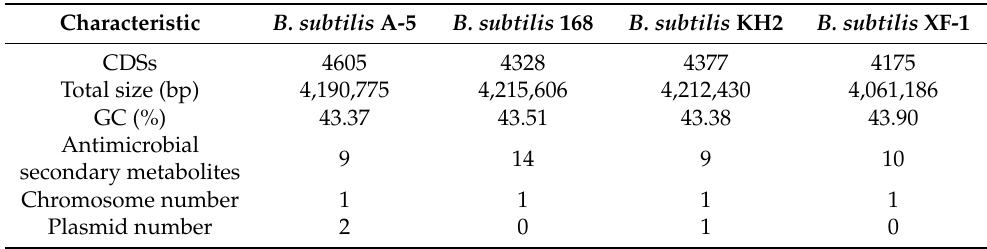
Table 4. Comparison of the characteristics of the whole genome sequences of B. subtilis A-5, 168, KH2, and